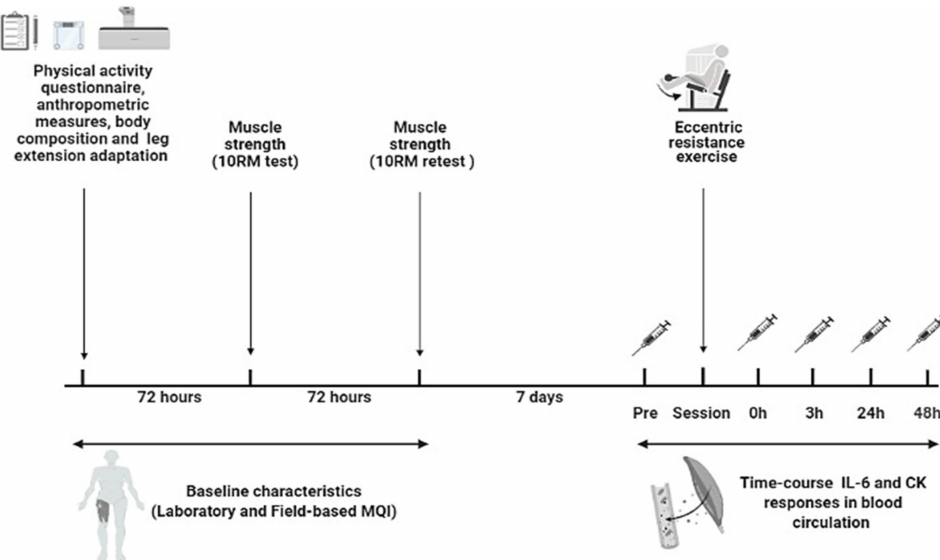
Figure 1. Schematic study design and timeline used to examine the time course of interleukin-6 (IL-6) and creatine kinase (CK) levels following acute eccentric resistance exercise in sedentary obese older women with different muscle quality index